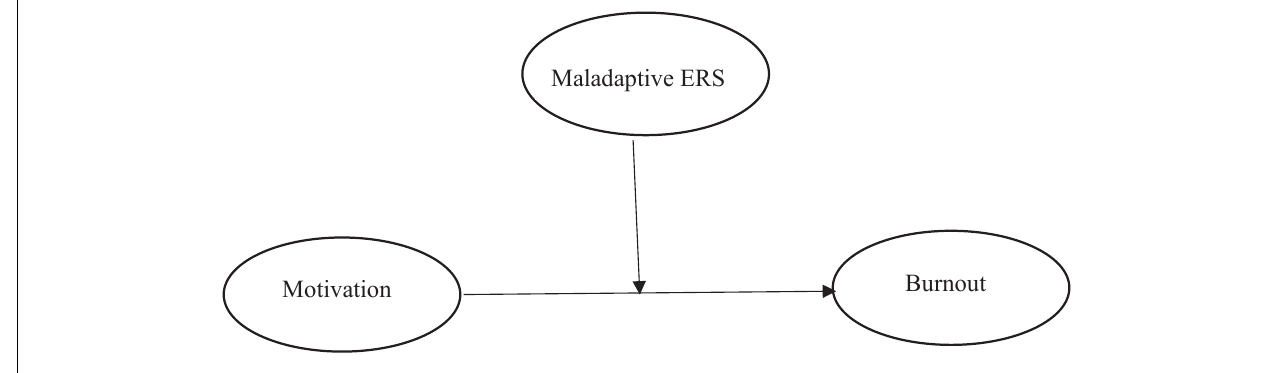
FIGURE 1 | Conceptual model of the current